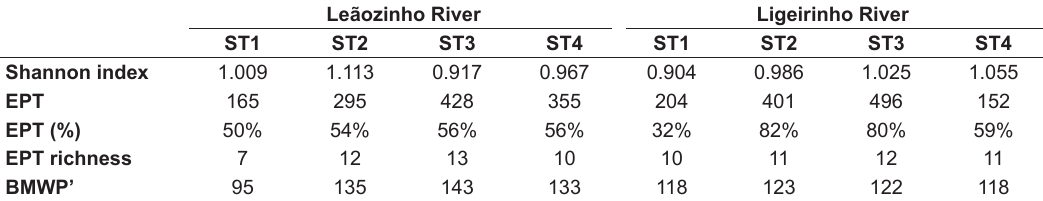
Table 2. Benthic macroinvertebrate (total indices) in the Leãozinho and Ligeirinho Rivers (Erechim, Rio Grande do Sul), by site (ST1-4), from November 2014 to April 2015.